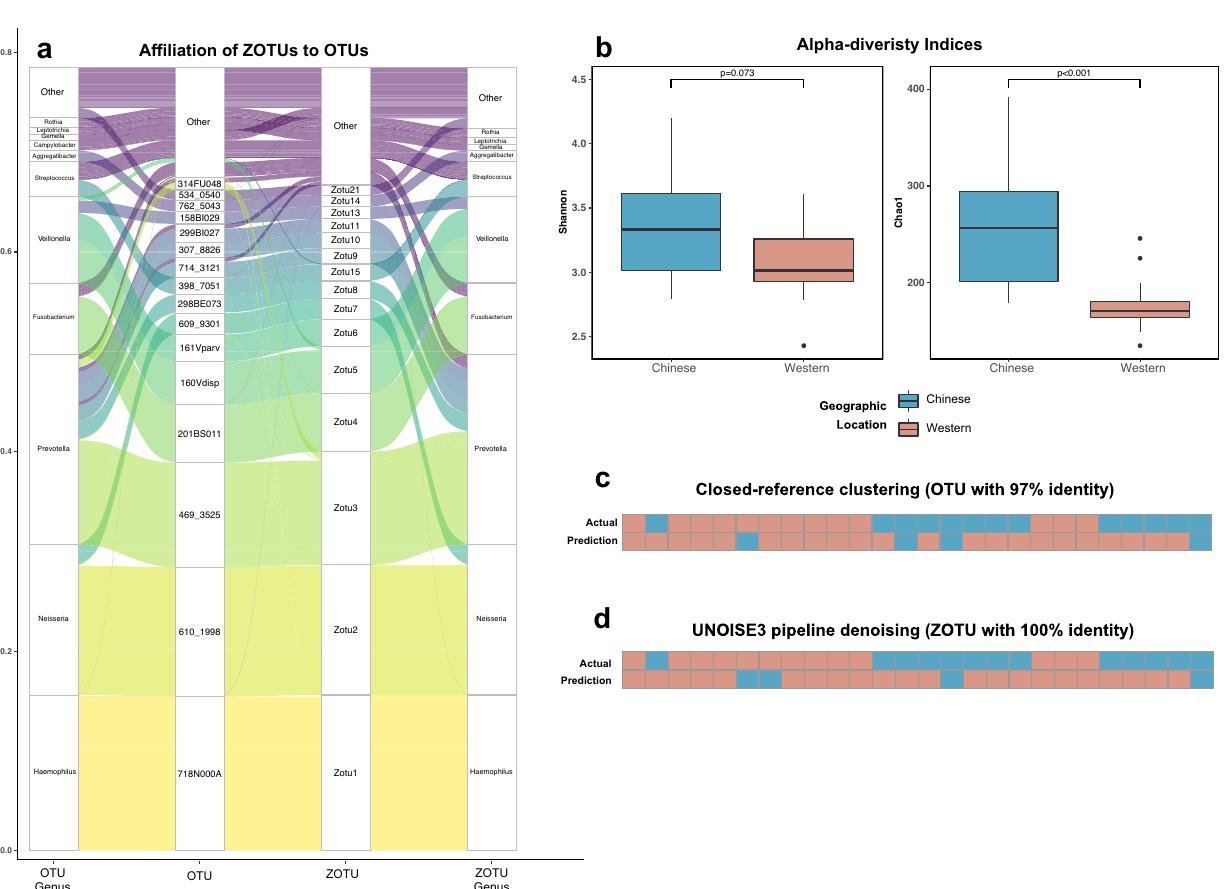
Fig. 7 An independent cohort veri fi es the de fi nition of core microbiome membership but cannot classify based on cultural background. a Alluvial plot showing the af fi liation of ZOTUs to their originating core OTUs de fi ned in the integrated analysis. b Comparison of salivary microbial alpha diversity between the Chinese and Western samples, calculated by Shannon ( p = 0.073, Wilcoxon rank-sum test) and Chao1 index ( p < 0.001, Wilcoxon rank-sum test), using the ZOTUs generated from denoising. c , d The prediction of the cultural backgrounds of the samples according to the random forest classi fi cation model constructed using the genus pro fi les of samples in the integrated analysis. The genus-level pro fi les of samples processed by d closed-reference clustering with 97% sequence identity and e UNOISE3 denoising with 100% sequence identity were used as the test hypervariable region. We found 48 genera identi fi ed as signi fi - cantly different by both methods (Fig. 6c and Supplementary Table 6). Finally, we performed the functional prediction-based 16S rRNA gene pro fi les to investigate the potential relationship between the differences in the salivary microbiota of the two groups and its function. Two methods, ANCOM-BC adjusted for the hypervariable region, and random forest model were used to identify which pathways were differential between Chinese and Western. The result of ANCOM-BC indicated that 69 pathways related to metabolism were differentially abundant between the two groups.